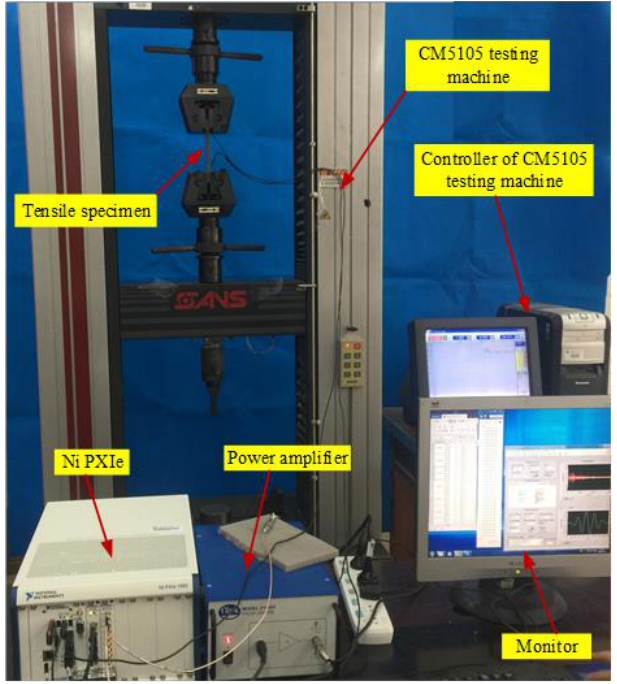
Figure 1. Experimental setup for the data acquisition system.